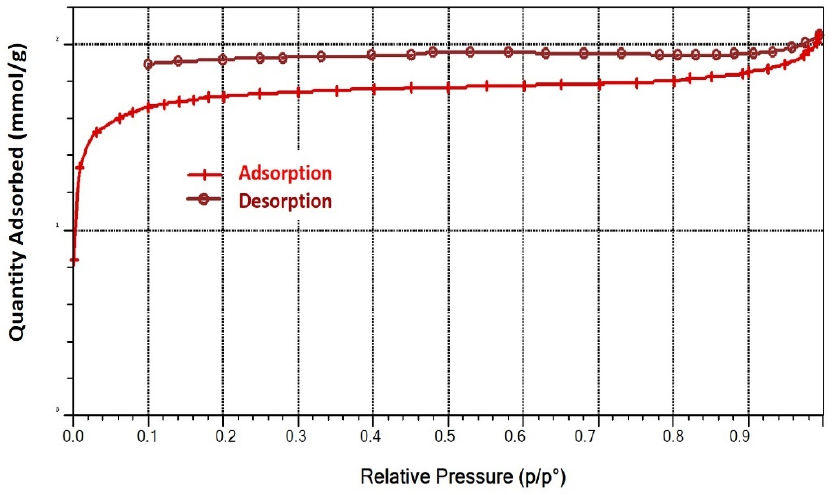
Figure 9. Adsorption–desorption isotherm curves of AC from palm raceme.